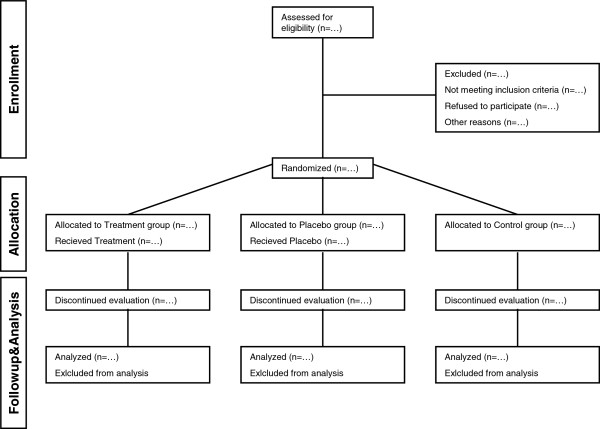
A flow diagram of the progress through the phases of the study.